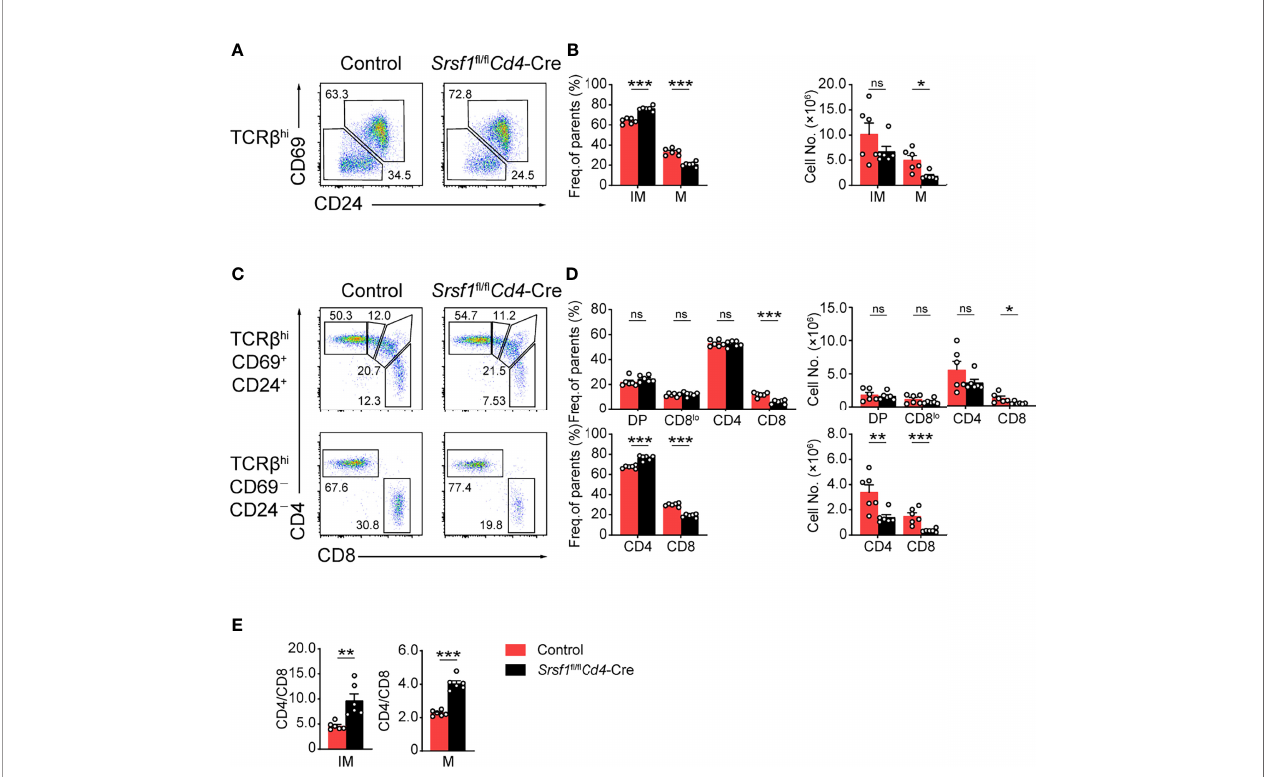
FIGURE 2 | Ablation of SRSF1 severely hinders the maturation of CD8 single-positive thymocytes. (A – D) Characterization of the post-selection thymocytes. (A) TCR b hi thymocytes (populations 4 and 5 in Figure 1F ) were further fractionated into CD69 + CD24 + immature (IM) and CD69 − CD24 − mature (M) subsets. The immature subsets were subdivided into CD4 + , CD4 + CD8 lo (CD8 lo ), DP, and CD8 + sub-populations (clockwise from top left in the top row), and the mature subsets were further subdivided into CD4 + and CD8 + populations (bottom row) (C) . The frequency and numbers of indicated subsets were shown in (B, D) , respectively. (E) The ratio of CD4 + to CD8 + thymocytes was calculated and shown (n = 6). Data were collected from at least three independent experiments. The error bars are means ± SD. Statistical signi fi cance was determined by one-tailed Student ’ s t -test. ns, not statistically signi fi cant; *P < 0.05 , **P < 0.01 , and ***P < 0.001